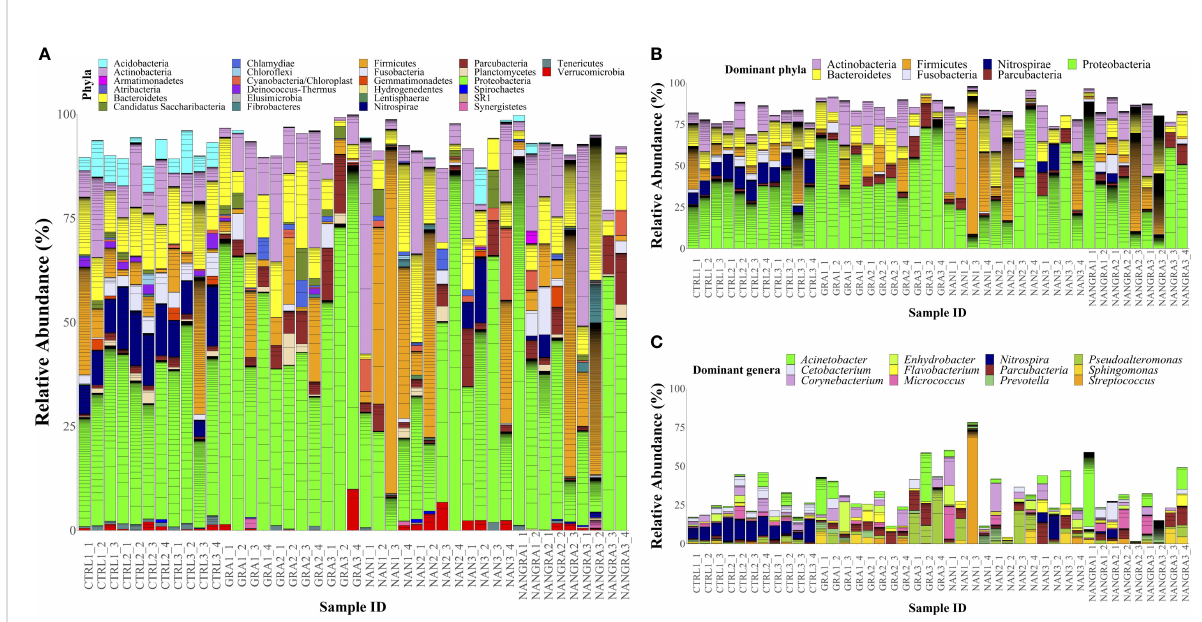
FIGURE 2 Relative abundance of the bacterial phyla (A) , dominant phyla (B) and dominant genera (C) in the posterior intestine of European seabass fed the experimental diets. Sample ID: CTRL, control group; GRA, Gracilaria gracilis group; NAN, Nannochloropsis oceanica group; NANGRA, G gracilis and N. oceanica blend group. Color codes: Actinobacteria – pink, Bacteroidetes – yellow, Firmicutes – orange, Fusobacteria – lavender, Nitrospirae – dark blue, Parcubacteria – dark red, Proteobacteria – green. Unclassi fi ed bacteria are not shown in the fi gures.